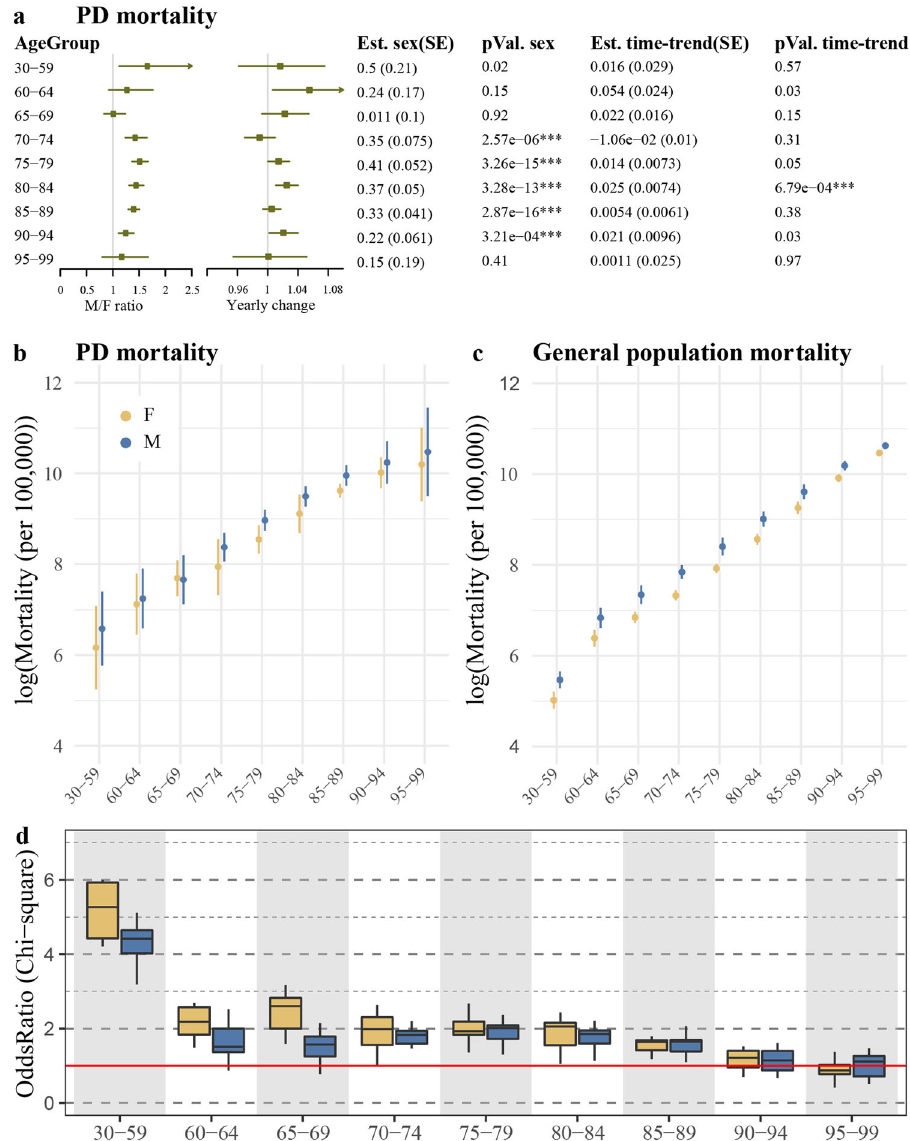
Fig. 2 Mortality of PD in the Norwegian population during 2005 – 2016. a The impact of the time period and sex on PD mortality were assessed individually for each age group, using Poisson regression. The p -values and the estimates for each covariate are shown in the tables. SE, standard error. M/F ratio and yearly change were derived by taking the exponential of the estimate for each covariate (sex or year). Lines represent the 95% con fi dence interval. b , c Natural log of mortality per 100,000 person-years in PD ( b ) and general population ( c ). The points indicate the mean mortality during 2005 – 2016, and the line indicates two standard deviations. d Death odds ratio of individuals with PD compared to general population were calculated for each year, separately for each age group, for females (yellow) and males (blue). Boxplots show the estimated odds ratios of the observation years. Red line indicates odds ratio of 1. The estimated odds ratio and the 95% con fi dence intervals for each observation year are shown in Supplementary Fig.